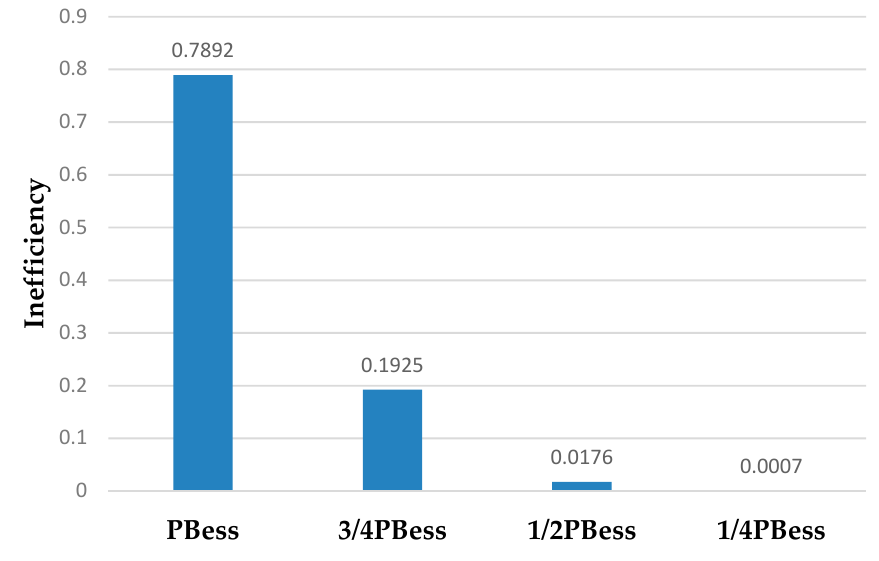
Figure 5. Partially inefficiency of the battery storage. Table 3. Binary contrast weighting method to calculate the weights of different risk levels.